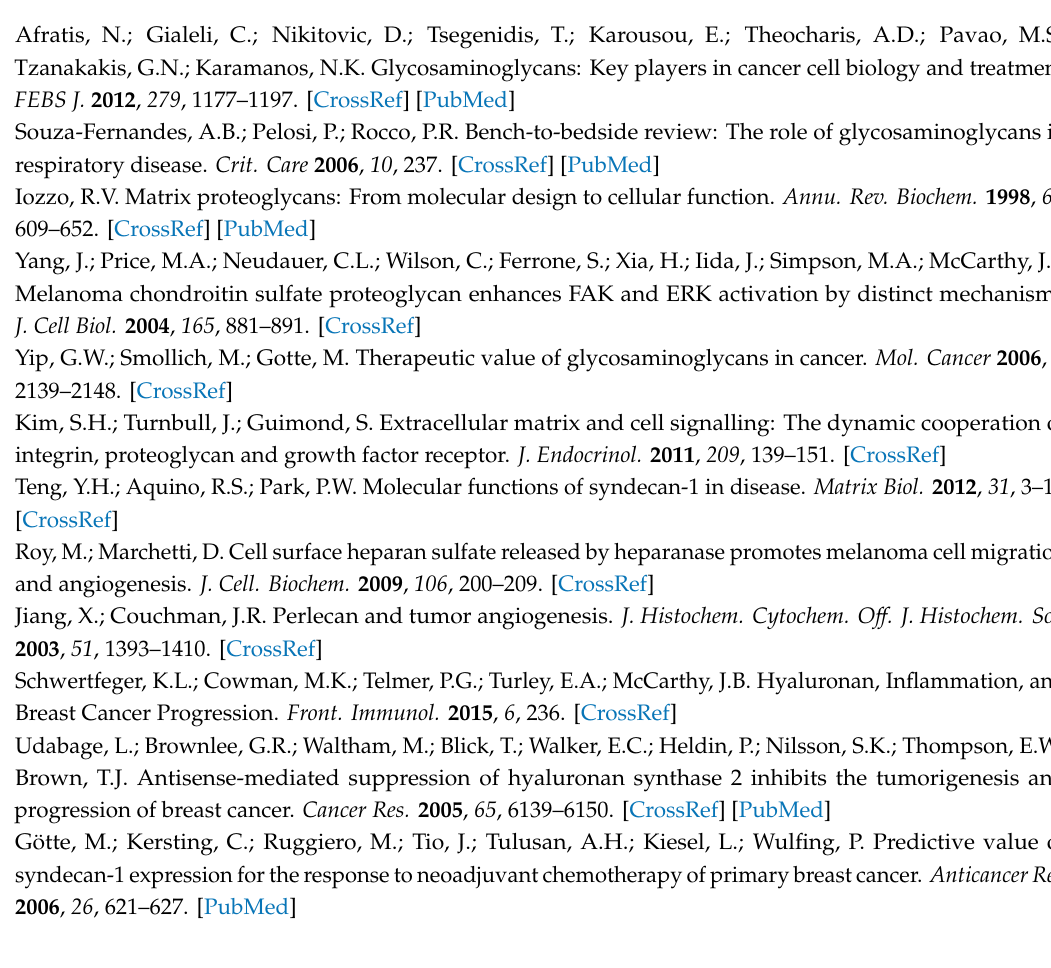
Supplementary Materials: The following are available online: Figure S1: Comparison between normalized mean second derivative spectra of GAGs extracted from conditioned media of four cell lines obtained by two methods. High-throughput FTIR spectroscopy (full line) and FTIR imaging (dotted line) correspond to the spectra of Figures 1B and 2B, respectively. Spectra are o ff set for clarity. MCF7 (red curves), MDA-MB-231 (blue curves), SKBR3 (green curves), and SUM149 (black curves).Figure S2: Illustration showing white light images of MDA-MB-231, SKBR3 and SUM149 single fixed cell (left) and their corresponding FTIR images (right). Scale bar: 10 µ m. Figure S3: Normalized mean second derivative spectra ± SD of CM-HT-FTIR from (A) MCF7, (B) MDA-MB-231, (C) SKBR3 and (D) SUM149. Figure S4: Normalized mean second derivative spectra ± SD of CM-imaging-FTIR from (A) MCF7, (B) MDA-MB-231, (C) SKBR3 and (D) SUM149. Figure S5: Normalized mean second derivative spectra ± SD of Cell-imaging-FTIR from (A) MCF7, (B) MDA-MB-231, (C) SKBR3 and (D) SUM149. Figure S6: Normalized mean second derivative spectra ± SD of Cell-Synchrotron-FTIR from (A) MCF7, (B) MDA-MB-231, (C) SKBR3 and (D)